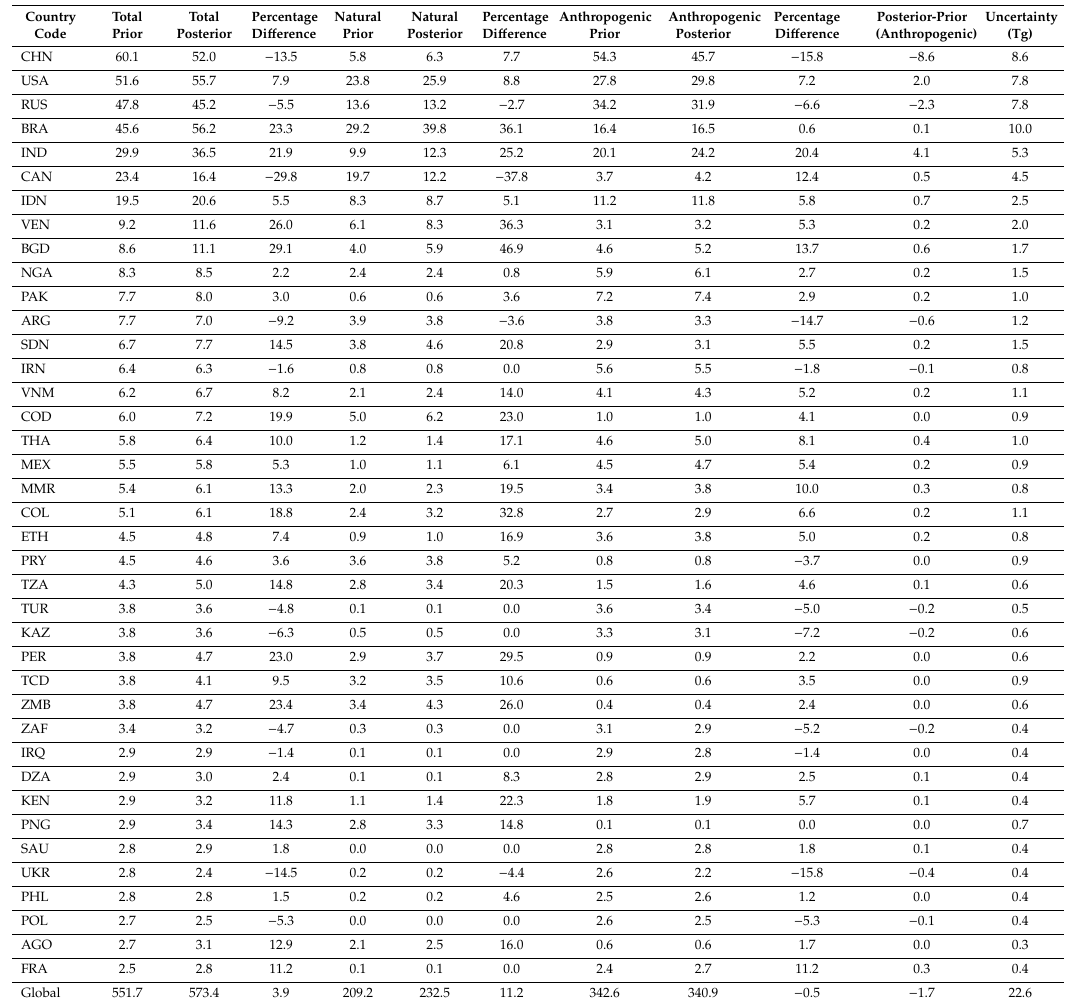
Table 1. List of countries with annual emission (natural or anthropogenic) greater than 2.5 Tg CH 4 . Annual priorand posterior emissionfor total, natural, and anthropogenic categories andtheir percentage di ff erence after optimization are given. The final row corresponds to global values. Country codes are listed against country names in the appendix, Table